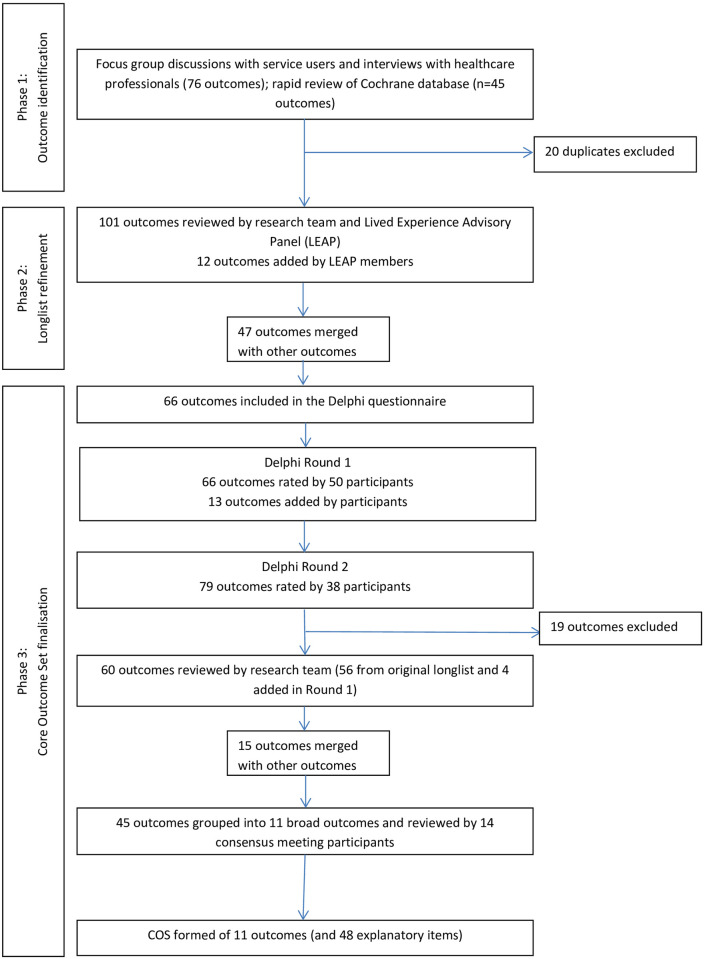
Illustration of core outcome set development process.